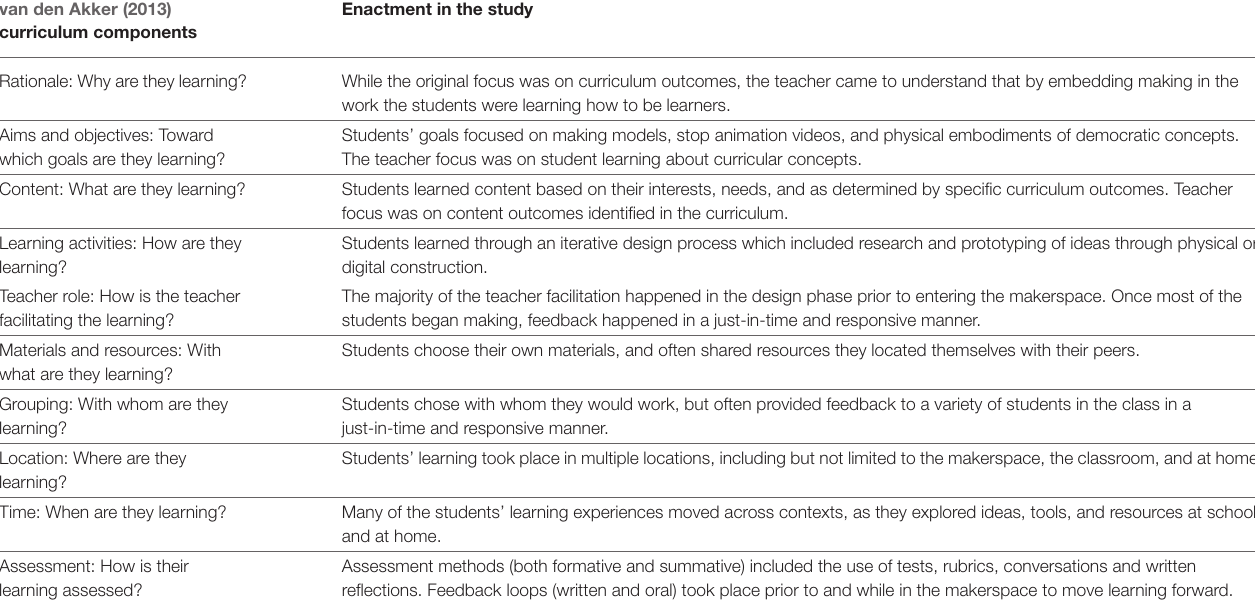
Enactment in the